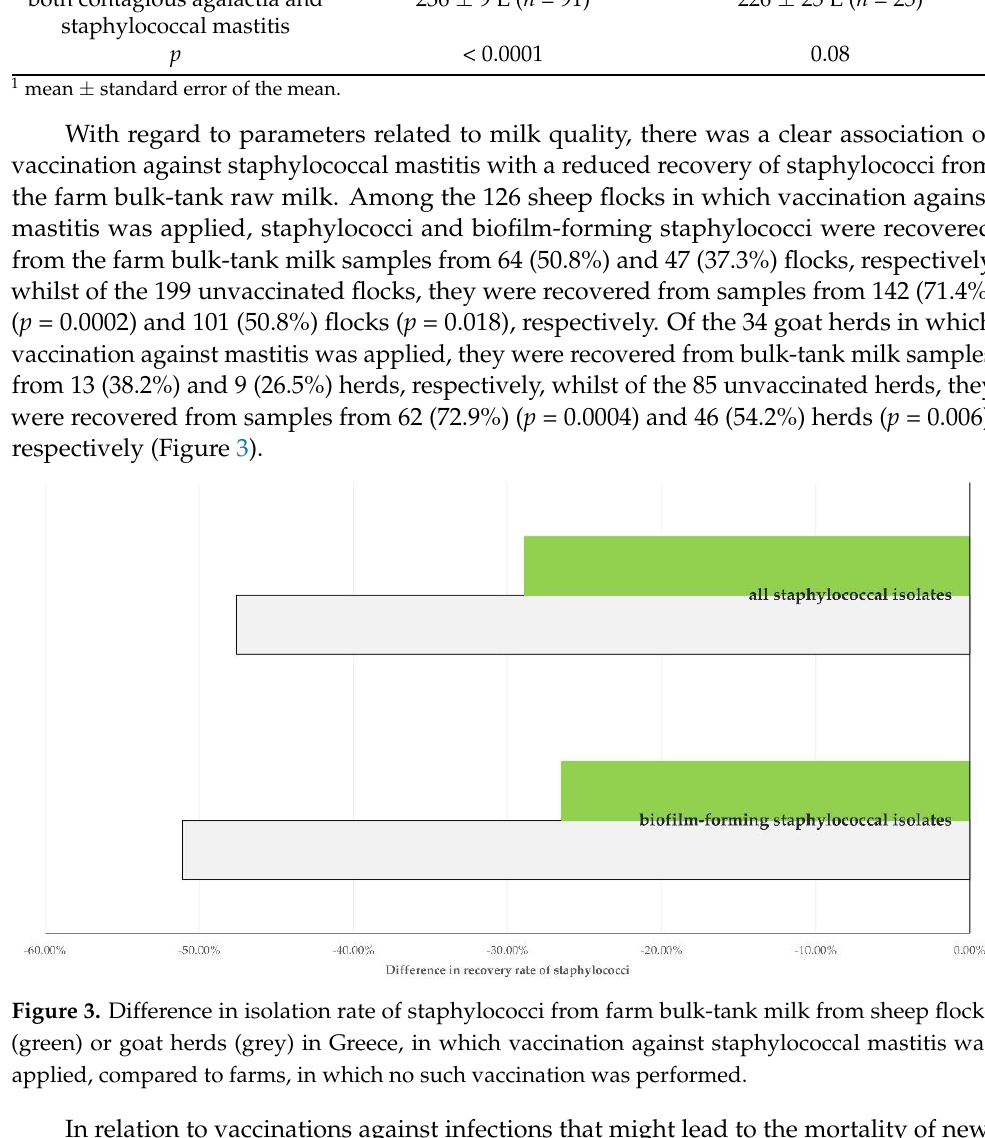
Figure 4. Proportion of newborns that were sold of those born, in sheep flocks (green) or goat herds (grey) in Greece, according to the total number of vaccines against two infections that might lead in death of affected newborns, which were used in the farms (bars show 95% CIs). In contrast, in relation to vaccinations against infections that might lead to the mor- tality of adult animals (clostridial infections, contagious agalactia, paratuberculosis, pneu- monia, staphylococcal mastitis), in goat farms, there was a clear association between the total number of vaccines administered against those infections and the annual incidence rate of mortality of adult animals: 6.30% (95% CIs: 5.94 – 6.68%) in herds where up to two